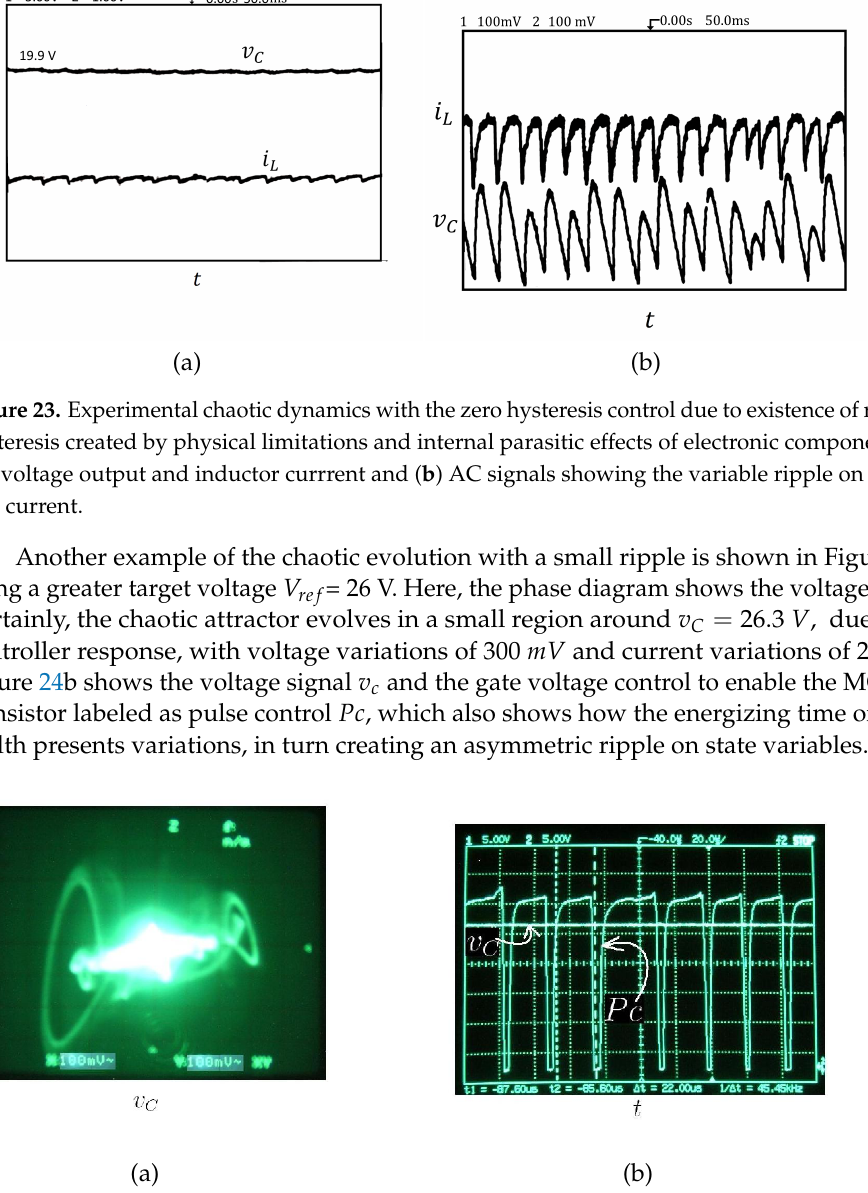
Figure 24. Experimental dynamic behavior with residual zero hysteresis control ξ (cid:39) 0 V, plotting ( a ) phase diagram and ( b ) temporal